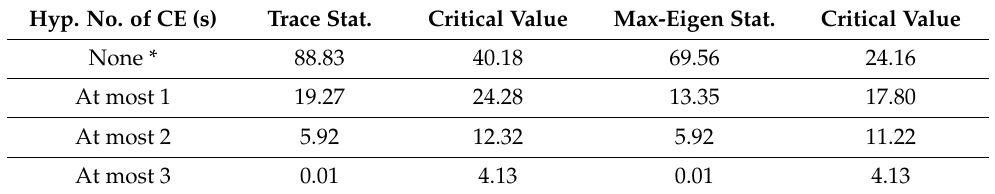
Table 6. Results of the Johansen Cointegration Test for Health Outcomes (Infant Mortality). Hyp. No. of CE (s) Trace Stat. Critical Value Max-Eigen Stat. Critical Value None * 63.24 40.18 24.16 At most 1 At most 2